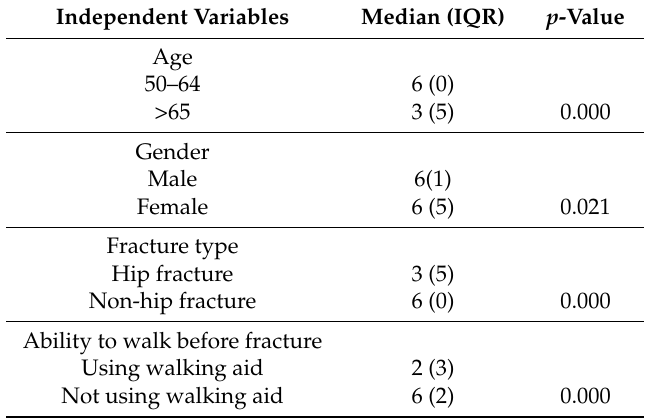
Table 7. ADL scores and independent variables (age, gender, fracture type and ability to walk before